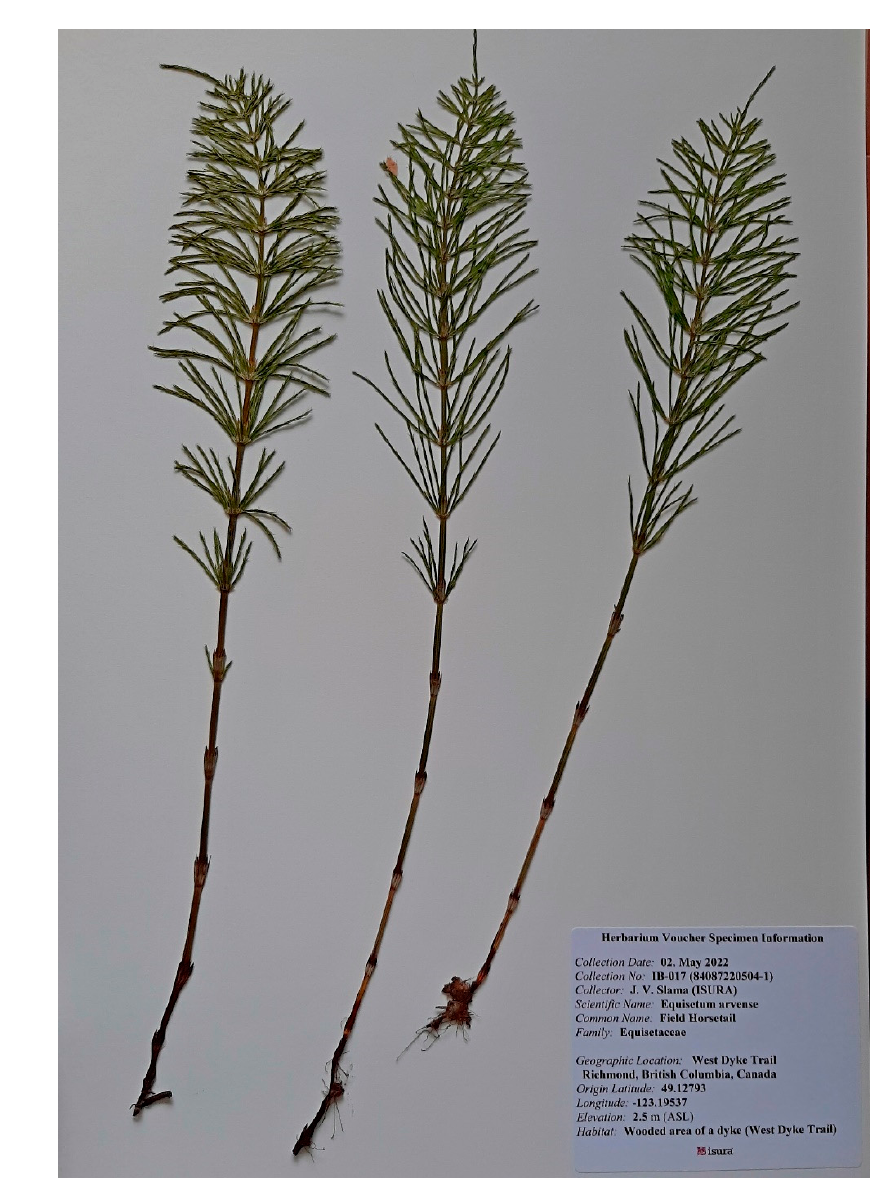
Figure 5. Wildcrafted E. arvense from ( a ) Burnaby (Test Code A8) and ( b ) Richmond (Test Code A9) in British Columbia, Canada.